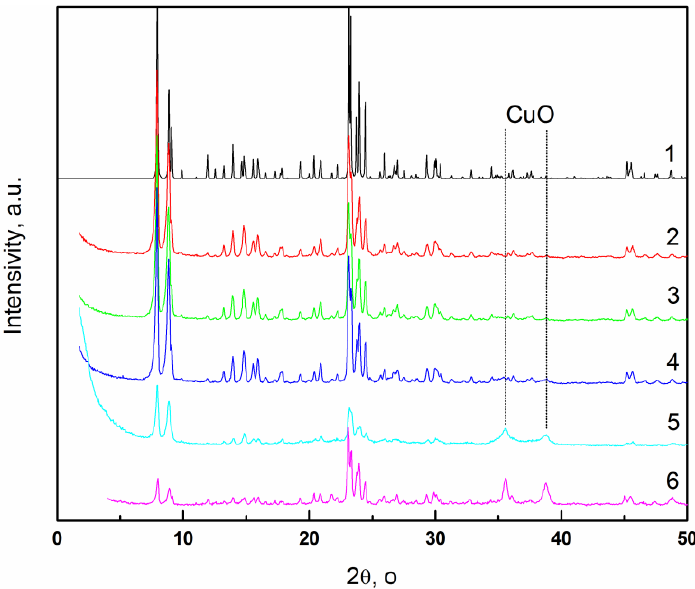
Figure 2. XRD patterns of Cu-MFI-SST samples with copper loadings 0 (1), 0.5 (2), 1 (3), 2 (4) and 16 wt.% (5). XRD of 16% Cu-ZSM-5-IMP presented for comparison (6). So, the studied Cu-containing silicalites and alumosilicalites had MFI structure.